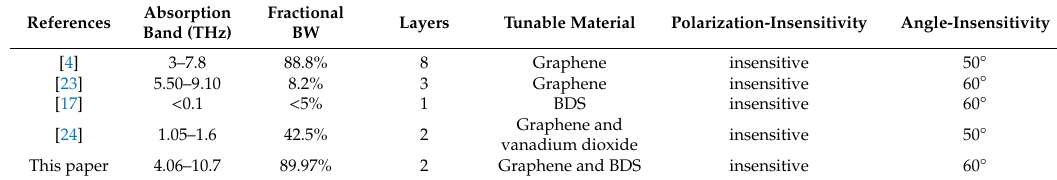
Figure 3. Absorption properties for different structures under normal incident TE and TM polarizations. Table 2. Comparison of parameters of THz absorbers based on graphene or BDS.